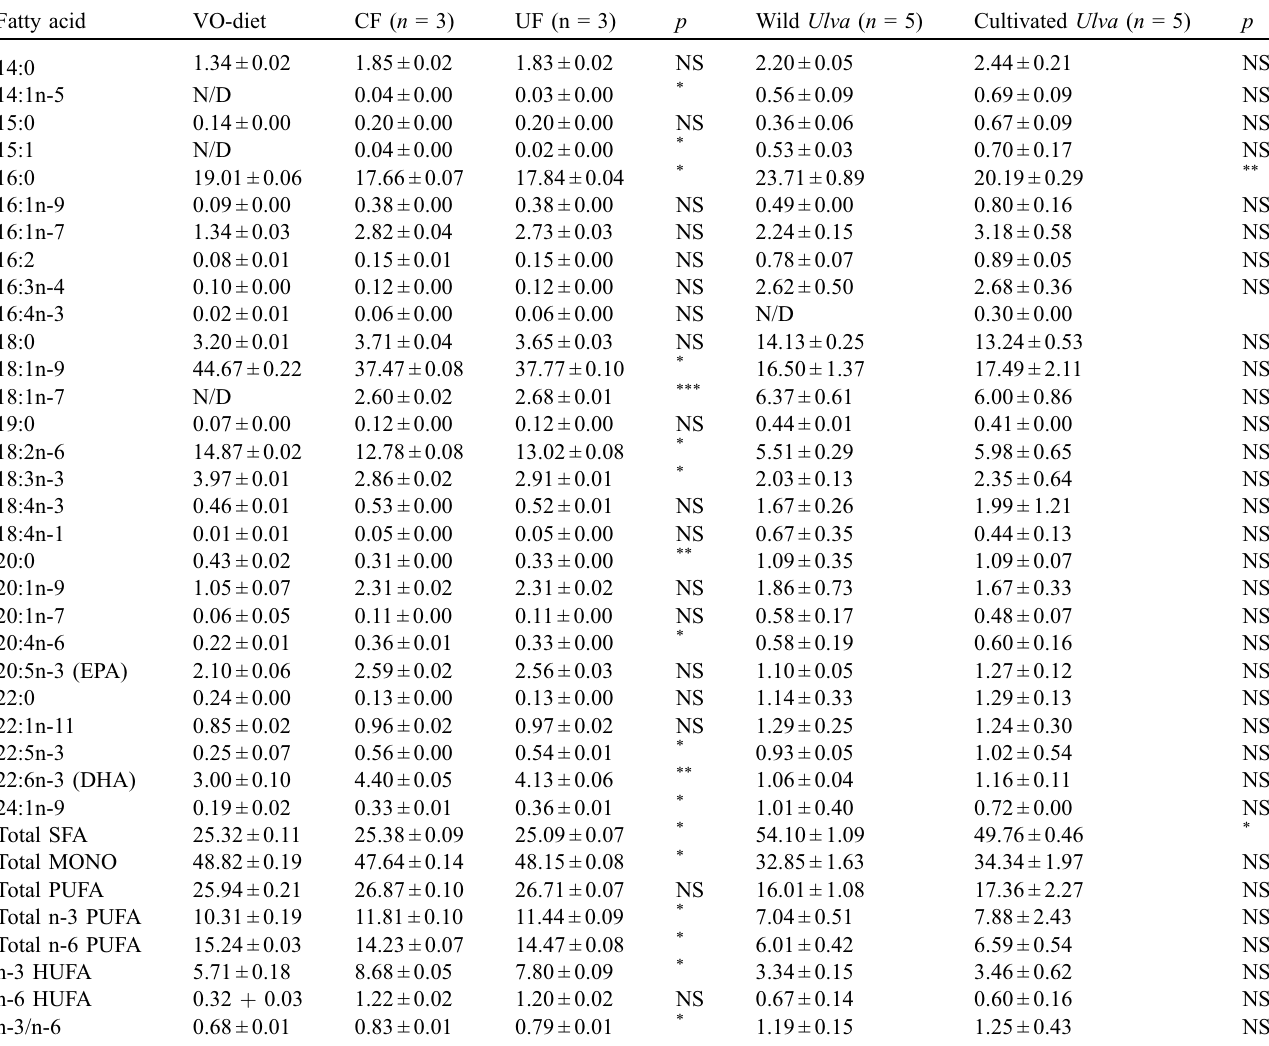
Table 8. Selected fi sh fatty acid pro fi le (% total identi fi ed fatty acids) of sea bass fed the VO-diet in CF ( fi sh group in control-RAS) and UF ( fi sh group in Ulva -RAS), as well as of wild and bi-weekly cultivated